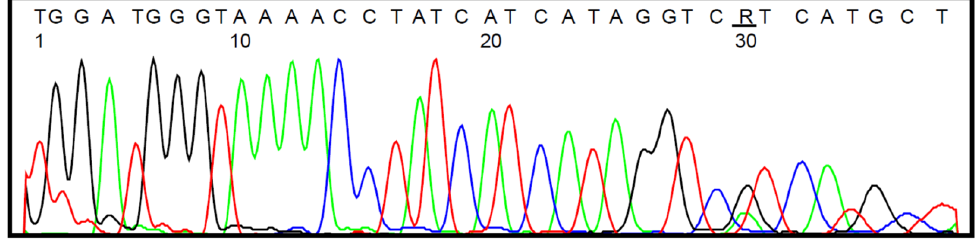
Figure 3. DNA sequencing data for IDH1 target amplicons showing the heterozygous IDH1 R132H/WT mutation in tumor sample #24 derived from GBM patient (the nucleotide of interest is underlined); SNP accession number: rs121913500.